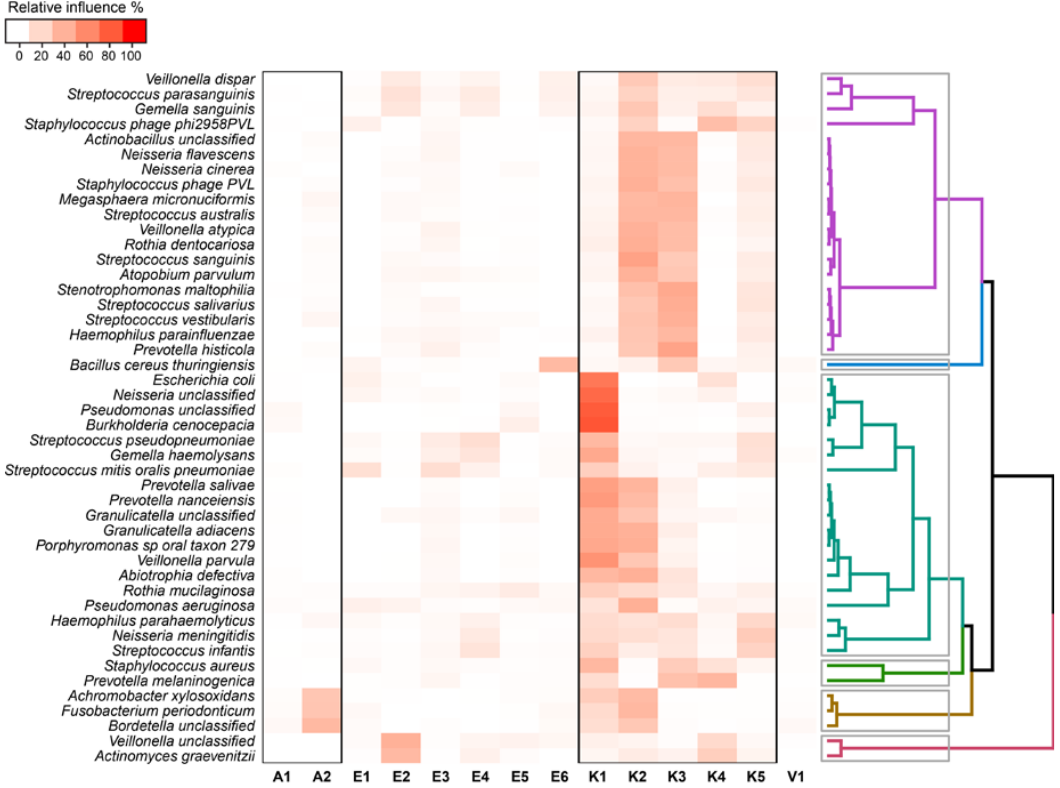
Figure 6. Relative influence of Kyoto Encyclopedia of Genes and Genomes (KEGG) pathways (K1 to K5), gene frequencies (evolutionary genealogy of genes: non-supervised orthologous groups (eggnog) database, E1 to E6), antibiotic resistance genes (Resfam database A1 and A2), and virulence factors (microbial database of protein toxins, virulence factors and antibiotic resistance genes for bio-defense applications (MvirDB), V1) for taxonomic structure of microbial lung community evaluated through “booster regression trees” models. The relative influence of different principal component to each bacterial species detected was clustered with the unweighted pair-group method with arithmetic mean (UPGMA) method based on Pearson’s correlation and a tree was reported on the right side of the plot. Boxes report the main group of taxa detected through a cluster analysis.